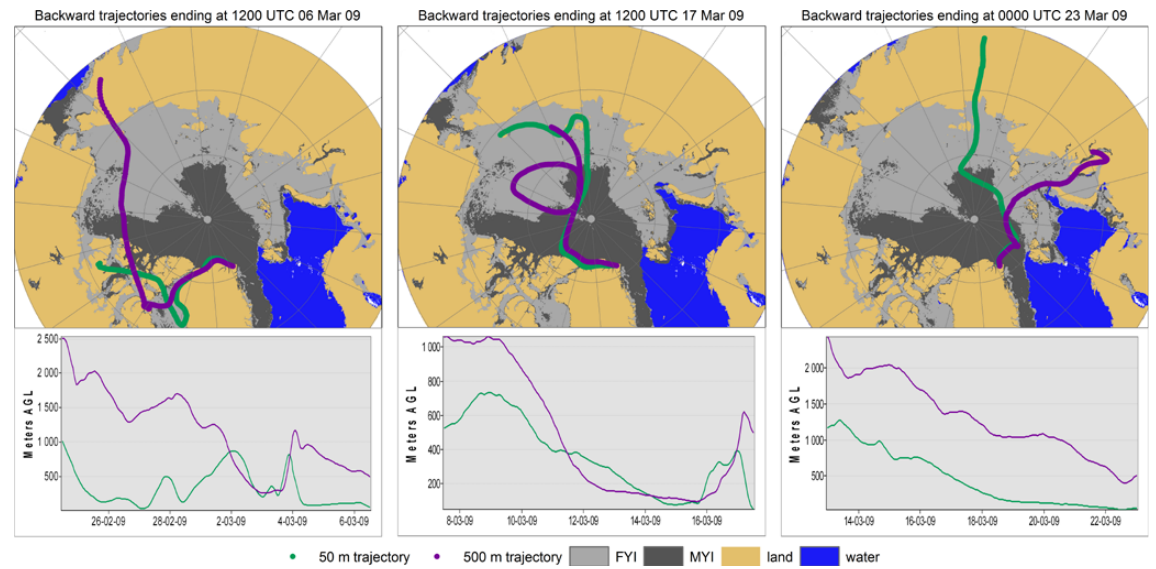
Fig. 7. Air mass back trajectories from the model HYSPLIT. The back trajectories are calculated for arrival at 50m and 500ma.s.l. every 12h. The trajectories are shown for three typical cases: (a) west of Station Nord, (b) along the coast of North Greenland and (c) north of Station Nord. For spatial reference the corresponding sea ice coverage and the continents are provided as background maps, showing first-year-ice (FYI) and multi-year-ice (MYI) listed in Table